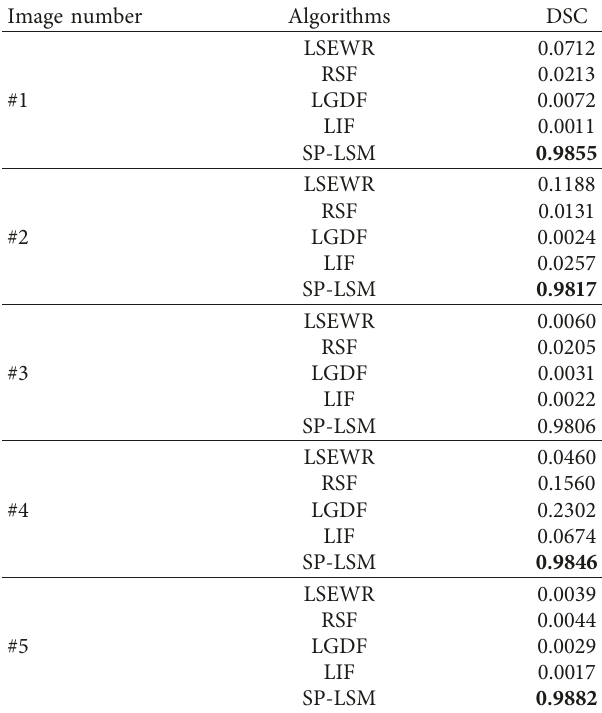
Figure 8: Comparison experiment for weak target edge capture applications. The first column is the input image along with initial contours. The second to sixth columns are the segmentation results by using the LSEWR, RSF, LGDF, LIF, and our SP-LEM models, respectively. The relevant task parameters are μ � 0 . 045, Δ t � 5 . 5, σ � 0 . 8, and ε � 2. Table 1: Segmentation metric for the five images in the first column of Figure